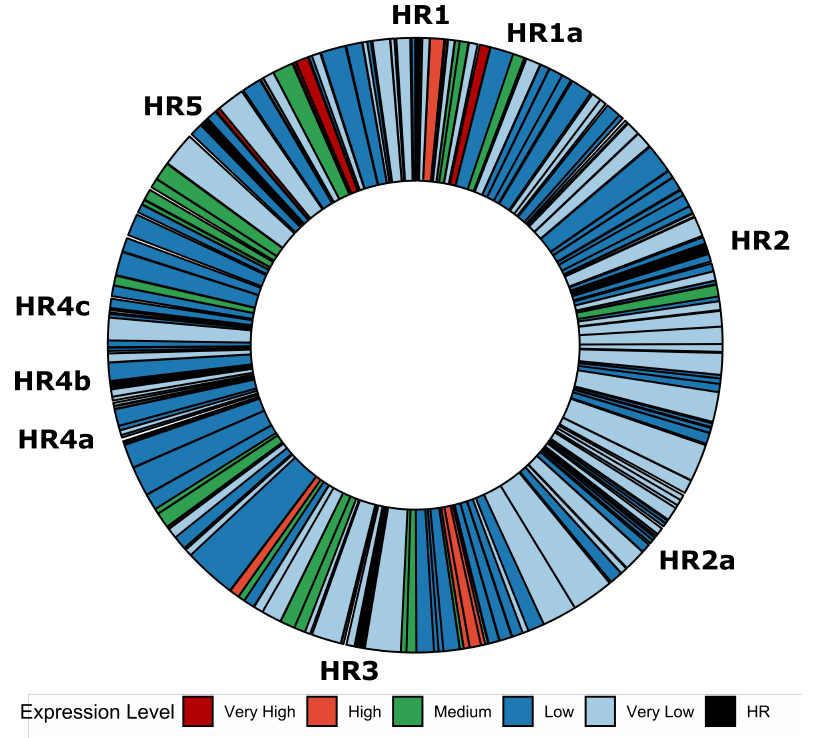
Figure 5. Circular chromosome map of Ac MNPV ORFs colour-coded according to transcript